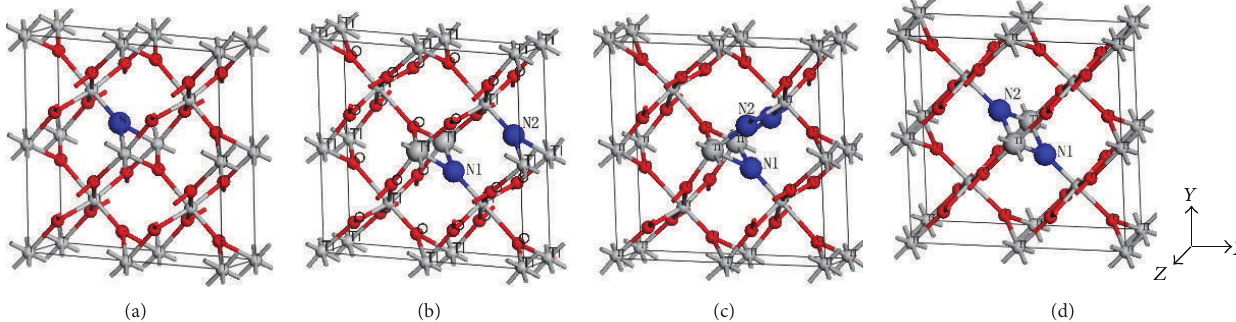
Figure 3: The structures of single N doped and double N doped-rutile TiO 2 . (a) Single N doped TiO 2 : (b) Model A of double N doped-TiO 2 ; (c) Model B of double N doped TiO 2 ; (d) Model C of double N doped-TiO 2